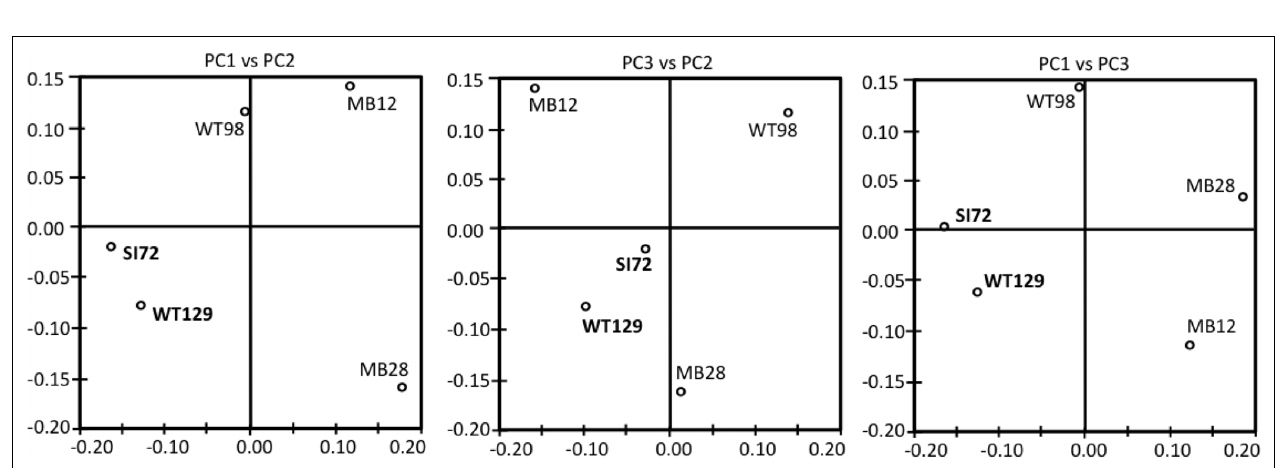
FIGURE 3 | Principal component analysis plots showing the clustering of 16S rRNA clone libraries based on shared OTUs, weighted for abundance. Each axis indicates the fraction of the variance in the data that the axis accounts for.The first and the second Principal Component explain most of the data ( P 1 = 41.4, P 2 = 30, P 3 =